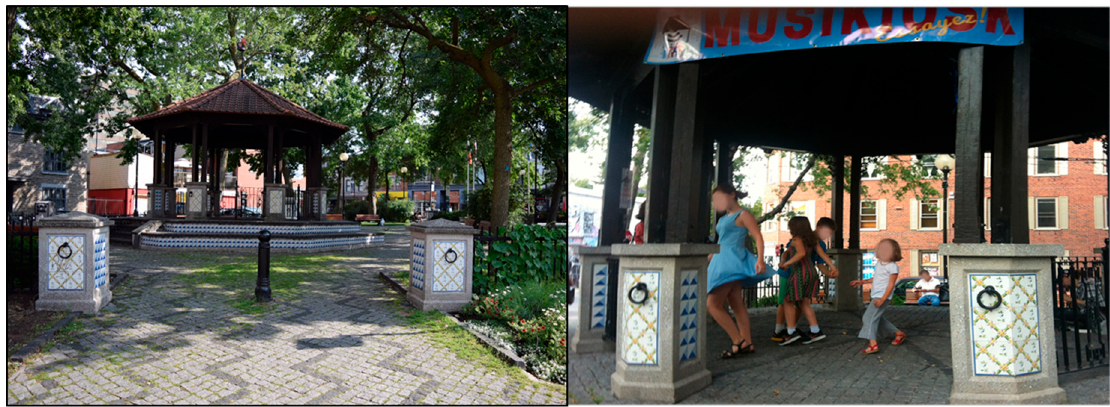
Figure 3. Left: gazebo in Parc du Portugal; right: users enjoying Musikiosk.